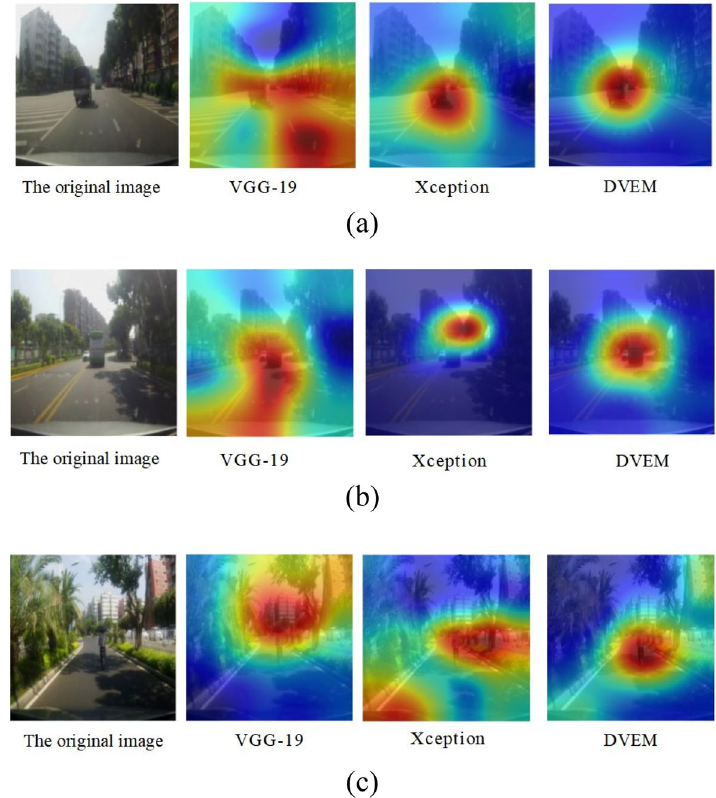
Figure 12. VGG-19, Xception, DVEM imaging results.